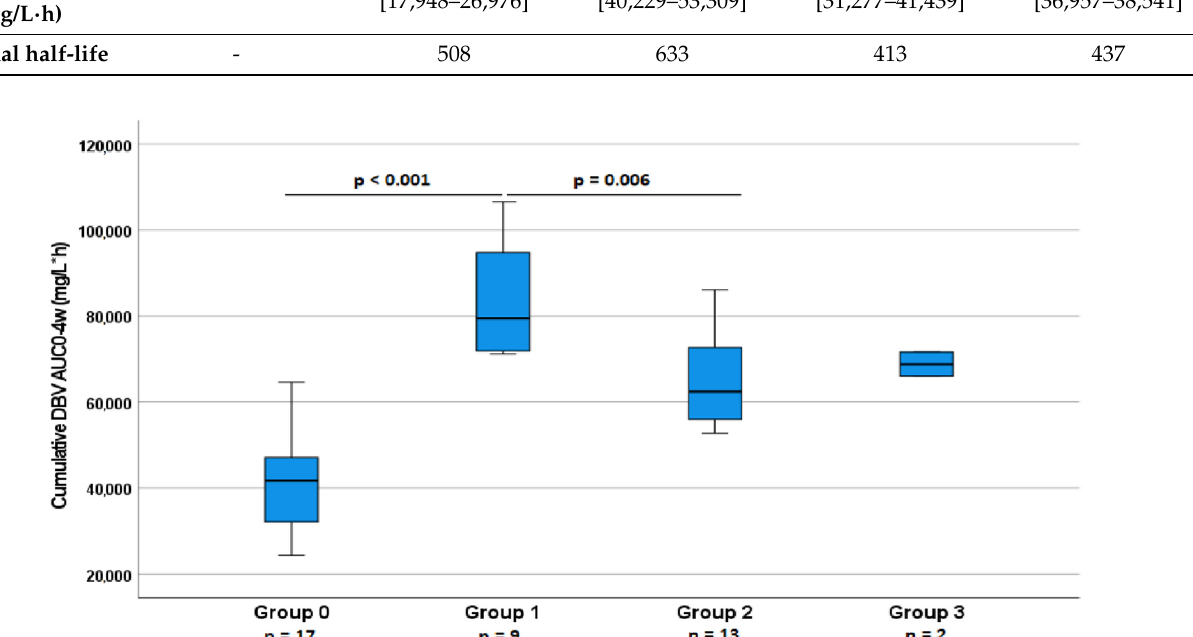
Figure 1. Cumulative AUC 0–4w for different dosing groups. DBV levels are expressed in mg/L·h. Cumulative AUC 0–4w of treatment was significantly higher for group 1 , compared with all the other dosing groups.